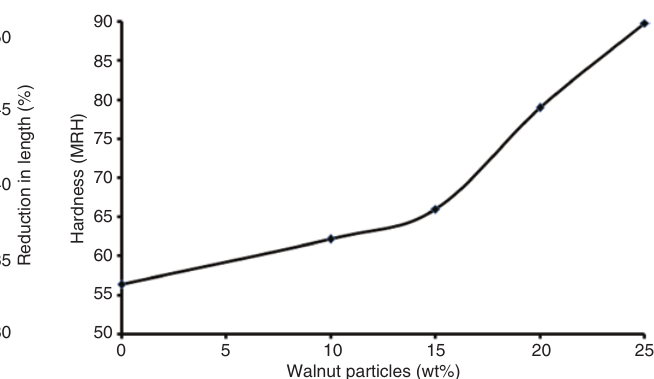
Figure 6 Hardness (MRH) for different weight percentage of walnut reinforced composite.